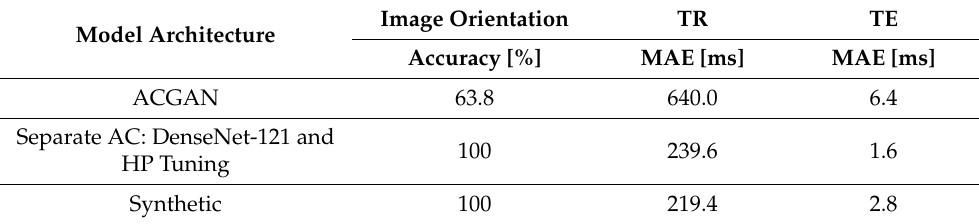
Figure 4. Additional examples of synthetic MR images with varying TR and TE to show the variety of the generated image samples. The imaging orientation alternates between sagittal and coronal. The images are annotated (in red) with acquisition parameter values as determined by the AC, showing a low overall conditioning error. Table 3. Auxiliary classification performance